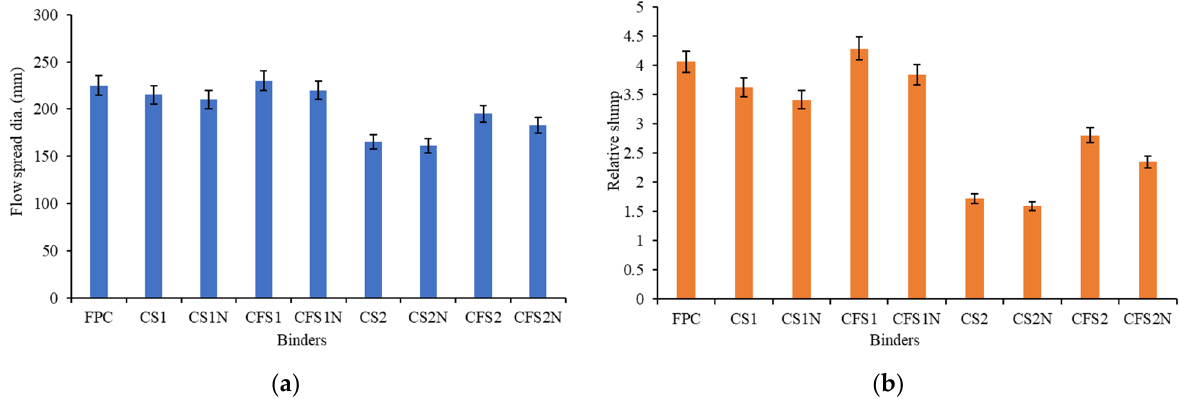
Figure 6. Workability characteristics of binders: ( a ) slump flow spread, ( b ) relative slump.